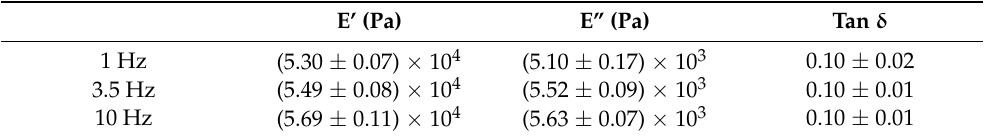
Table 1. Storage modulus (E’), loss modulus (E”), and tan delta of GGE scaffolds, measured by DMA at three different frequencies (1, 3.5, and 10